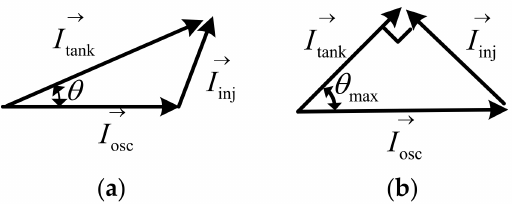
Figure 1. Phasor diagram for the current flown into the tank. ( a ) A general case. ( b ) The case when the maximum locking range is reached.